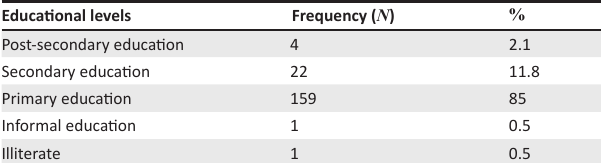
TABLE 3: Information use by education categories ( N =